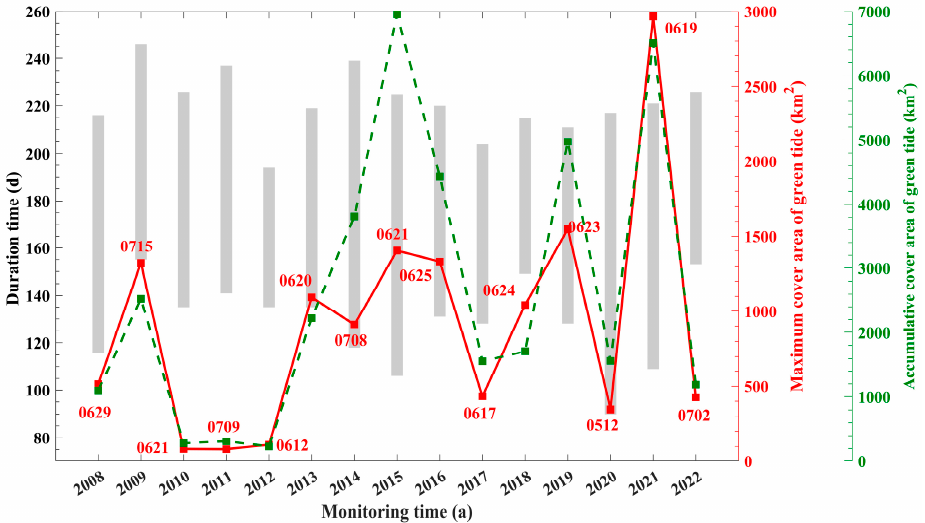
Figure 14. Results of simulation of the bloom duration and accumulative and maximum cover area of the Yellow Sea green tide from 2008 to 2022.